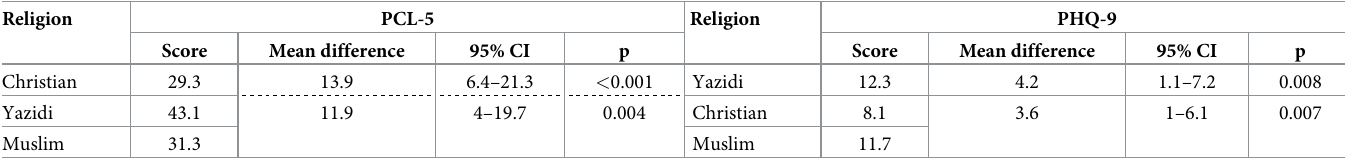
Table 2. Difference in PCL-5 and PHQ-9 scores between the three